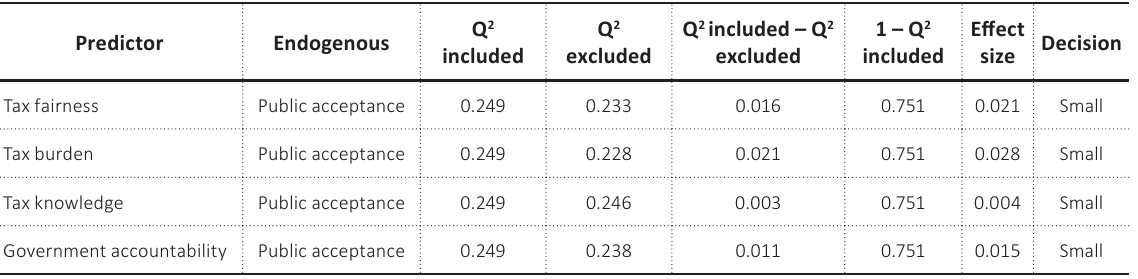
Table 8. Q-squared (Q 2 ) effect size